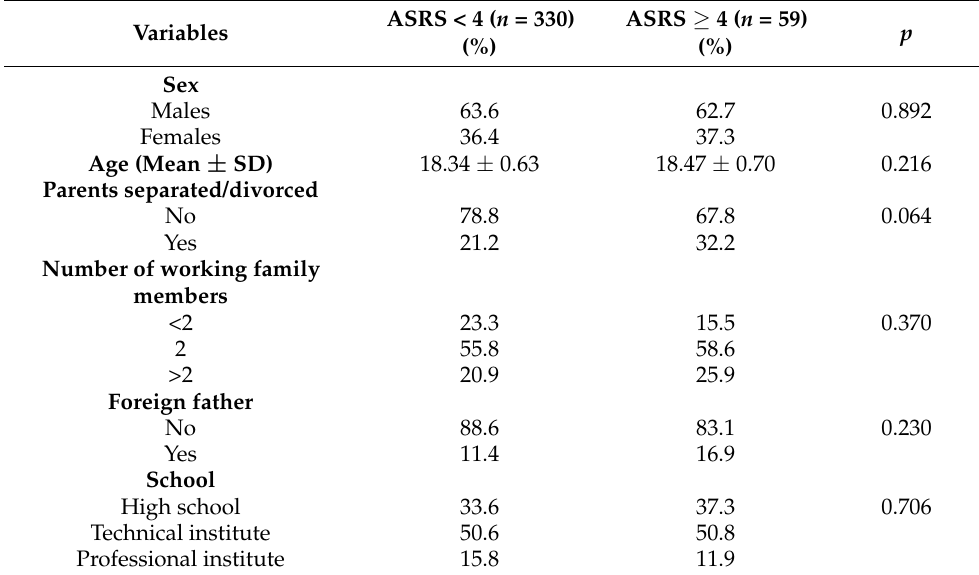
Table 2. Characteristics of the subjects divided by positive ADHD Self-Report Scale (ASRS) question- naire scores.